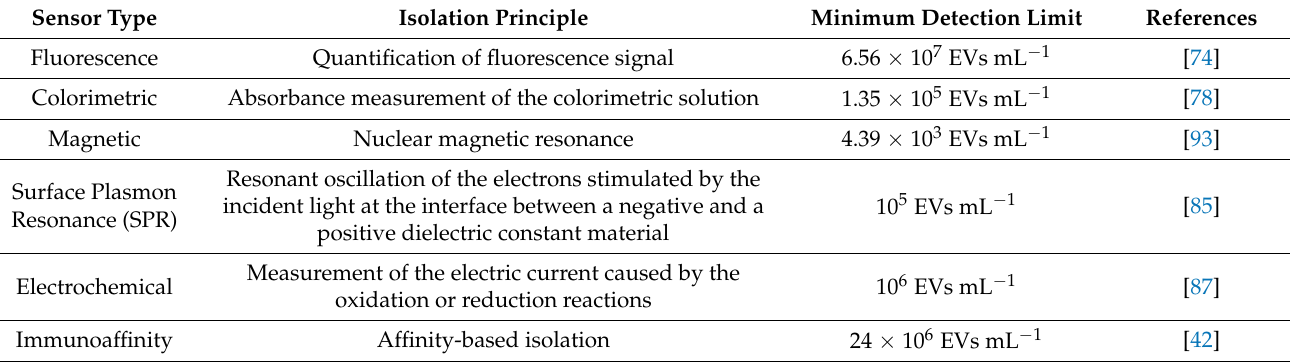
Table 2. Summary of the on-chip EVs detection techniques and reported limits of detection. Sensor